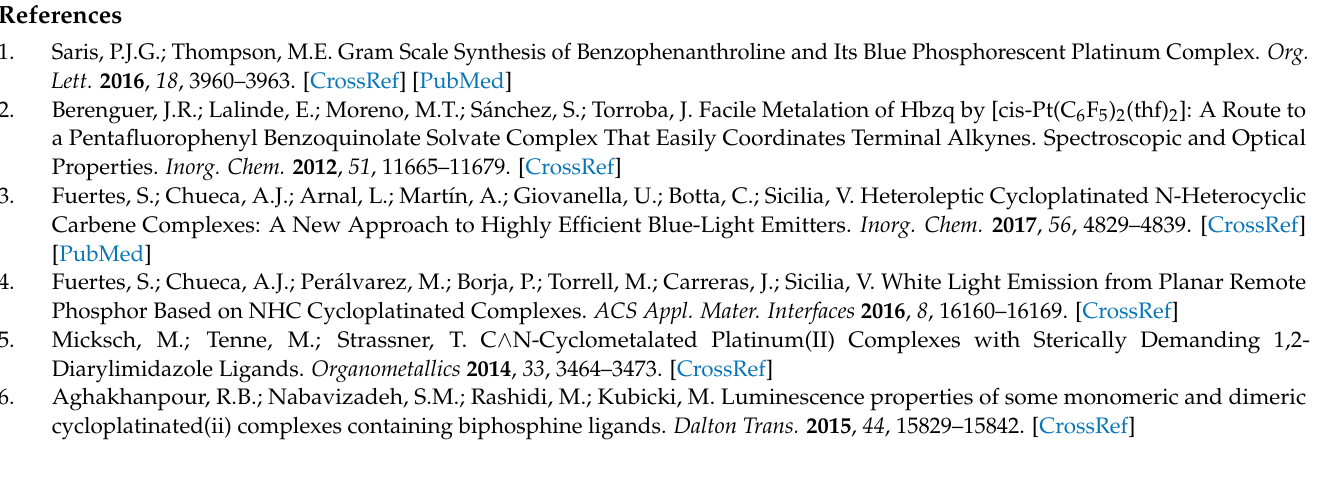
(c) 1c in CH 2 Cl 2 solvent, Figure S10: Selected MO plots of 1a , Figure S11: Selected MO plots of 1b , Figure S12: Selected MO plots of 1c , Table S1: Crystal data and structure refinements for 1c and 2c , Table S2: Selected geometrical parameters for the optimized structures of 1a-c , Table S3: Composition (%) of frontier MOs in the ground state for 1a in CH 2 Cl 2 solvent, Table S4: Composition (%) of frontier MOs in the ground state for 1b in CH 2 Cl 2 solvent, Table S5: Composition (%) of frontier MOs in the ground state for 1c in CH 2 Cl 2